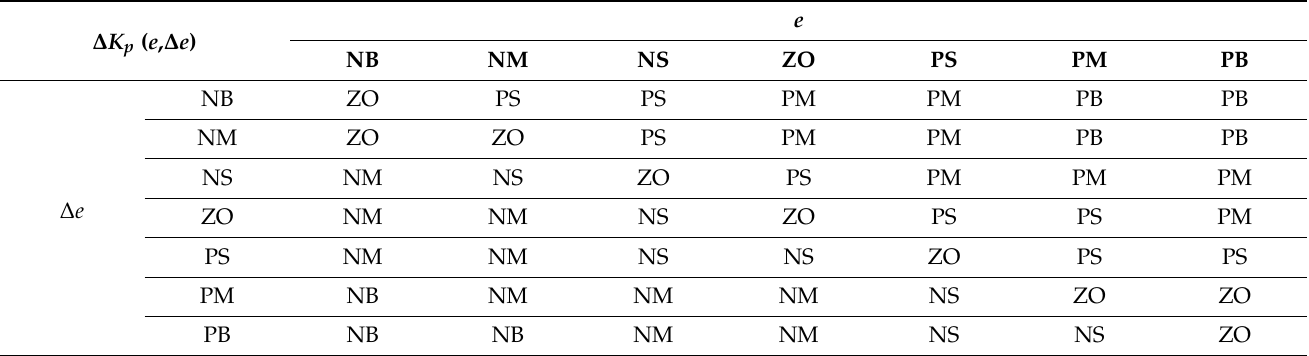
Figure 3. Membership functions of the fuzzy system, where a is set as 0.5 for joint angle error, while for the change of joint angle error, it is set as 0.01. Table 1. Fuzzy rule base table for proportional gain ∆ K p